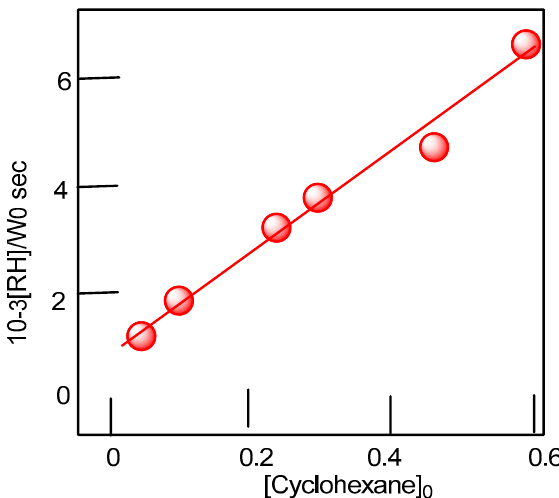
Figure 8. Linear anamorphosis of the dependence of the reaction rate on the concentration of cyclohexane (data in Figure 7) in accordance with equation (11).